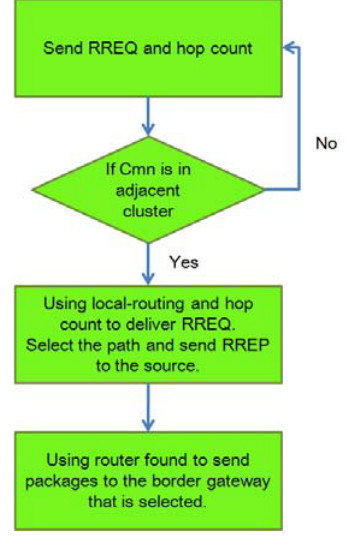
Figure 10. Inter-cluster search for routing algorithm.